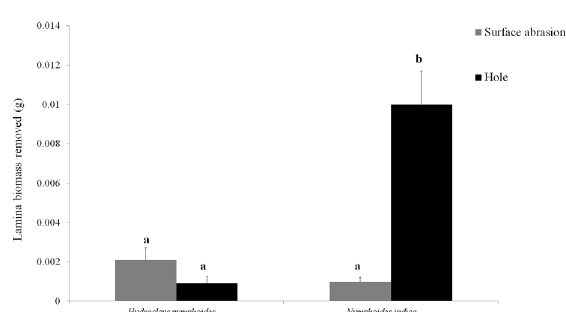
Figure 3 - The lamina biomass removed (g) by surface abrasion and holes per leaf lamina on floating-leaf macrophytes in decay period. Different letters indicate means statistically different between sampling